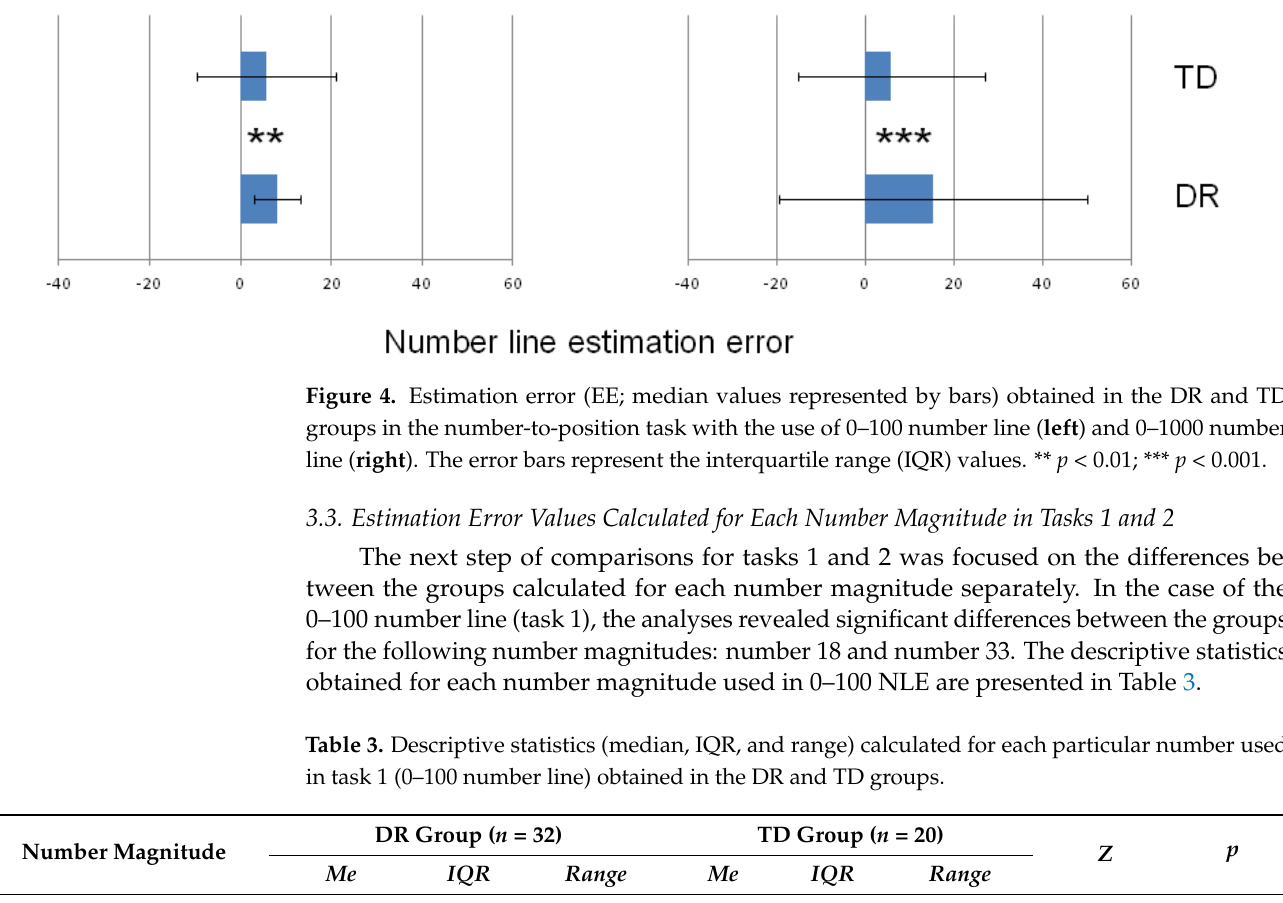
Table 3 . Descriptive statistics (median, IQR, and range) calculated for each particular number used in task 1 (0 – 100 number line) obtained in the DR and TD groups.